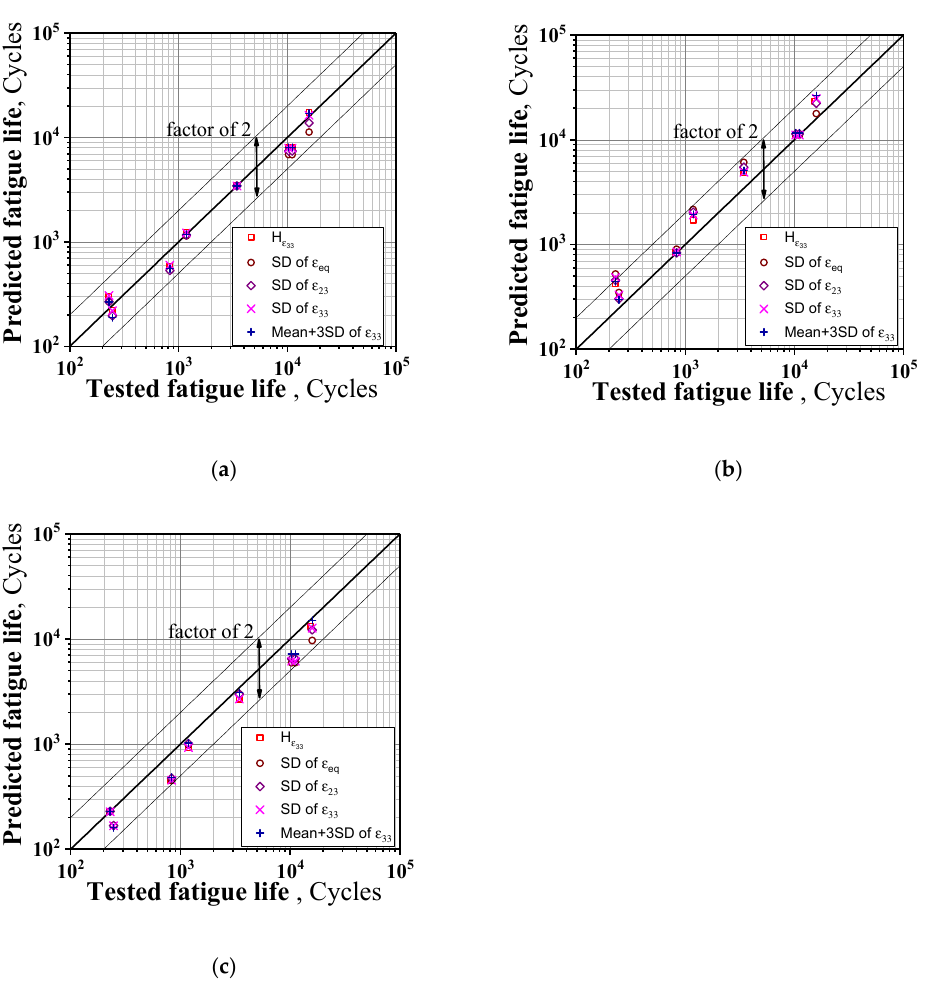
ˆ3 ε ε+ , ˆ ε , ˆ ε , ˆ ε and H : ( a ) ε 33 33 33 23 eq 33